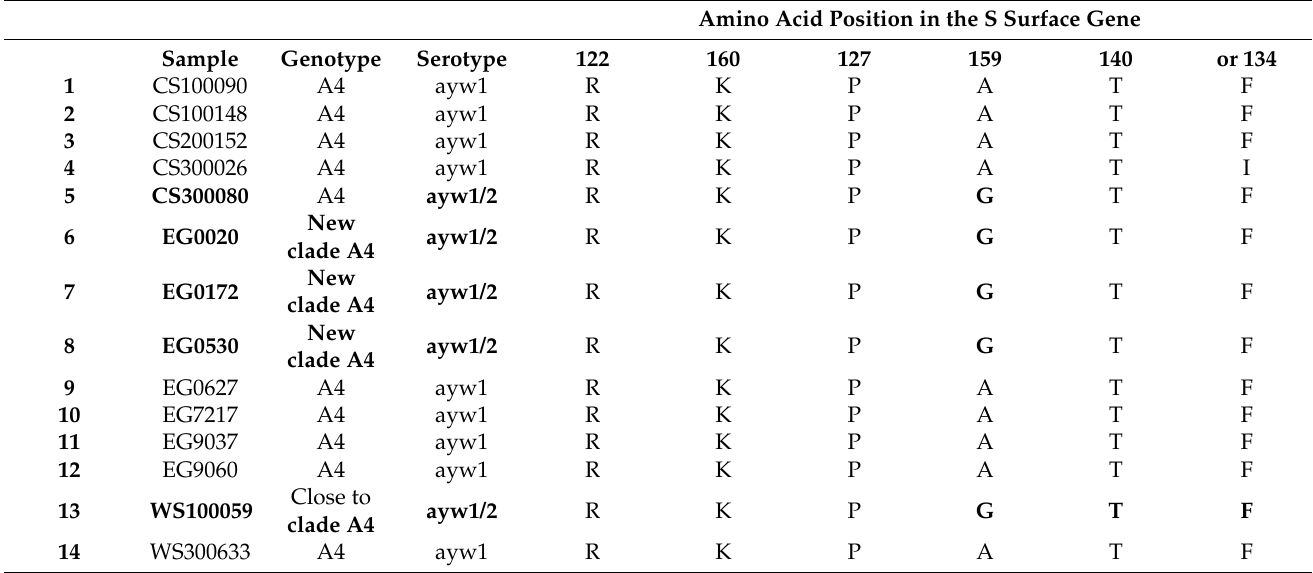
Table 2. Identification of subgenotype specific amino acid motifs in the S gene. Amino Acid Position in the S Surface